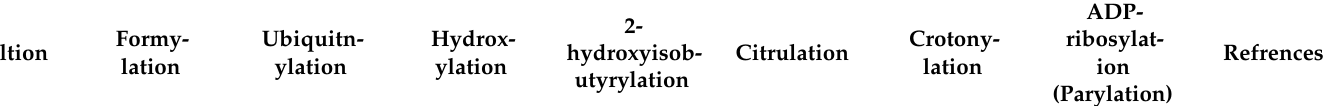
Table 1. Post-translation modifications of human linker histone